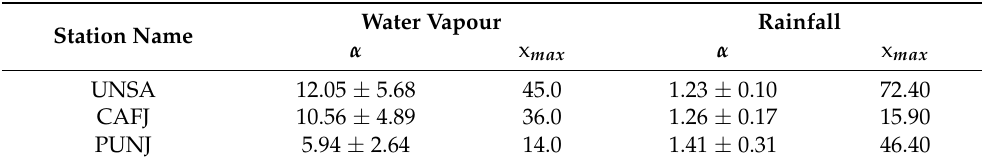
Figure 9. Power-law fitting of greater than the 90th percentile daily mean water vapour values ( left ) and the cumulative rainfall for the corresponding epochs ( right ) of the UNSA, CAFJ, and PUNJ stations. In both cases, the inputs (white dots) are grouped into 20 bins using a logarithmic scale. The minimum value (x min ) for the water vapour modelling was set to the lowest-magnitude bin, whereas the daily sums lower than 0.01 mm were omitted for the rainfall fitting. Table 3. Statistical attributes for α and its standard deviation and x max of the power-law fitted lines in Figure